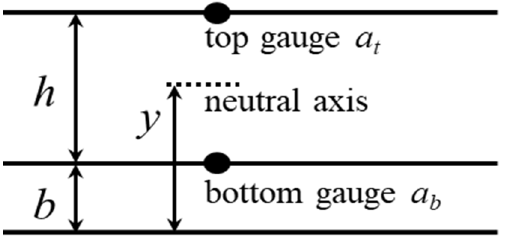
Figure 1. A cross-section with two parallel gauges measures strains at the top a t and at the bottom a b . By assuming linear strain distributions, the neutral axis height y is found as the intercept of the strain diagram a t and a b .